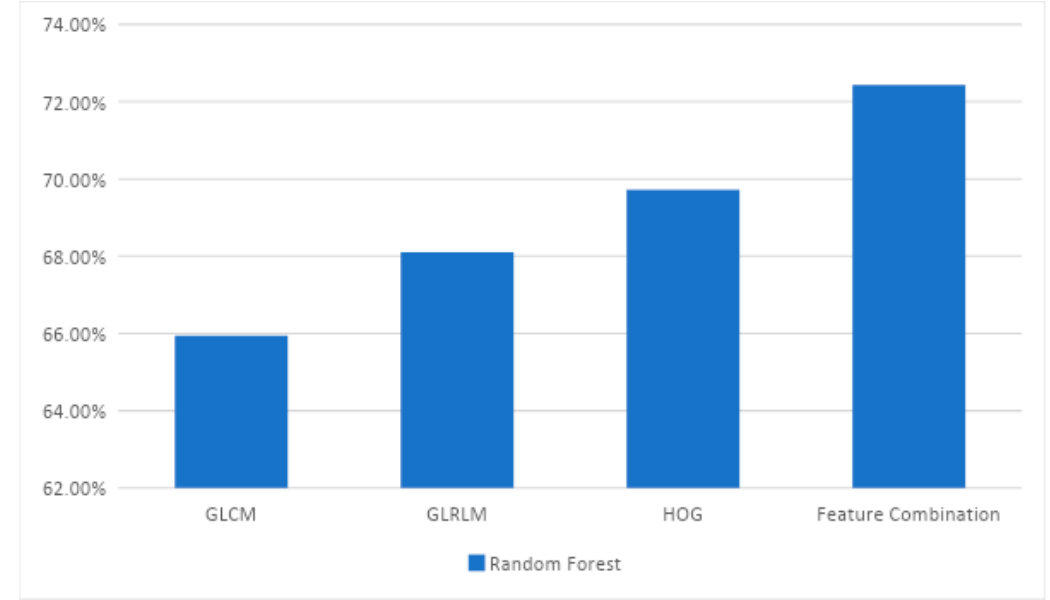
Figure 3. Comparison of accuracies by the random forest classifier for all feature extraction techniques on Dataset-I. Table 10. GLRLM results on Dataset-II.